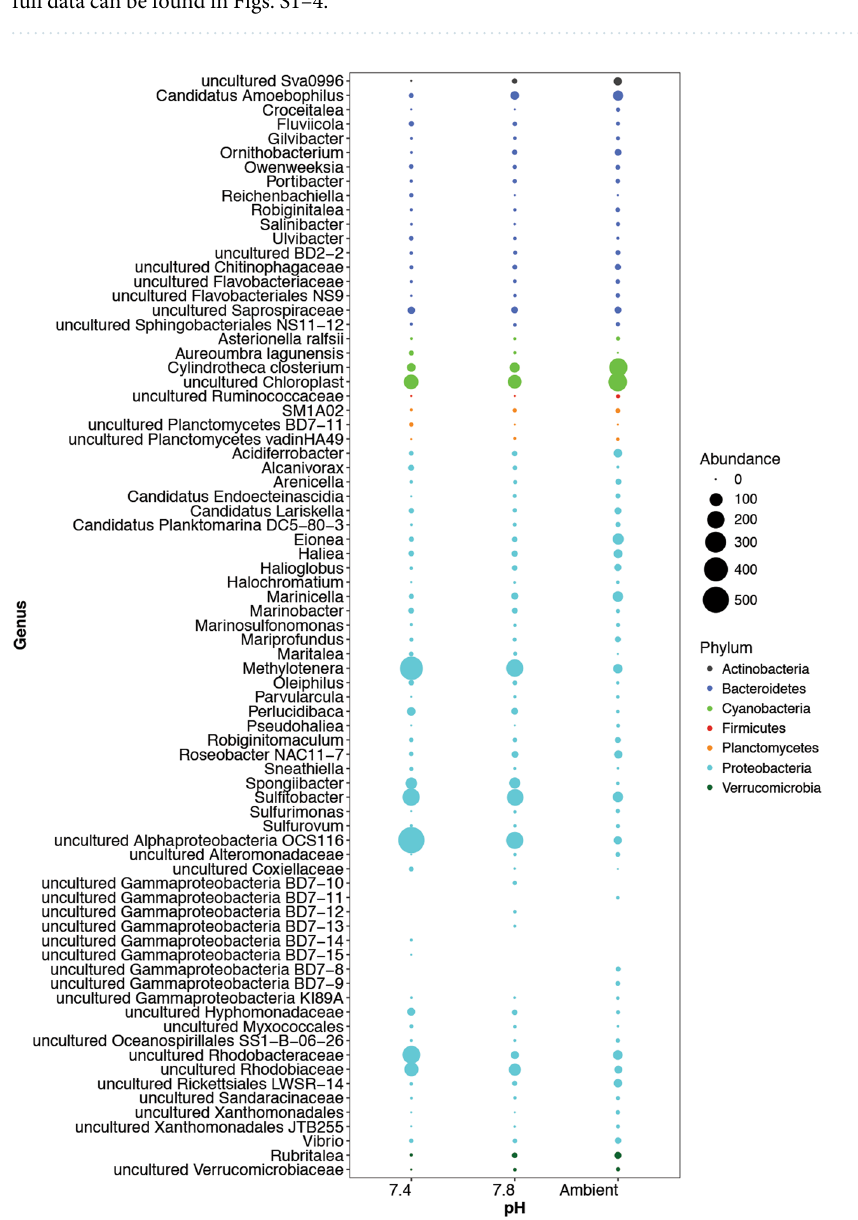
Figure 4. Summary of significantly affected microbial genera based on OTUs correlated to pH. Data represents 198 OTUs with a significant (p < 0.05) Spearmans correlation (Rho <− 0.5 and >